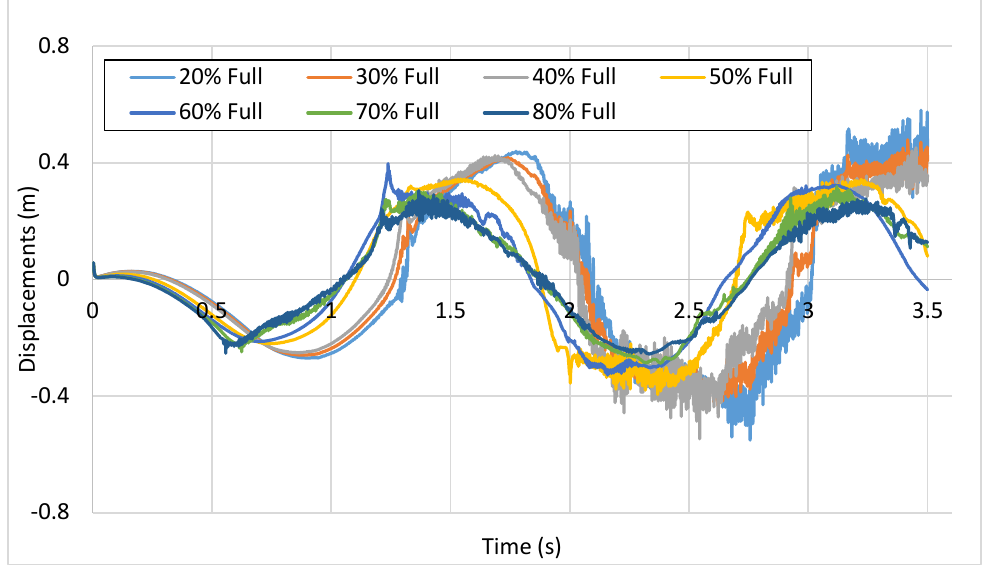
Figure 12. Displacement of horizontal component of ZMP vs. time at different fill levels.